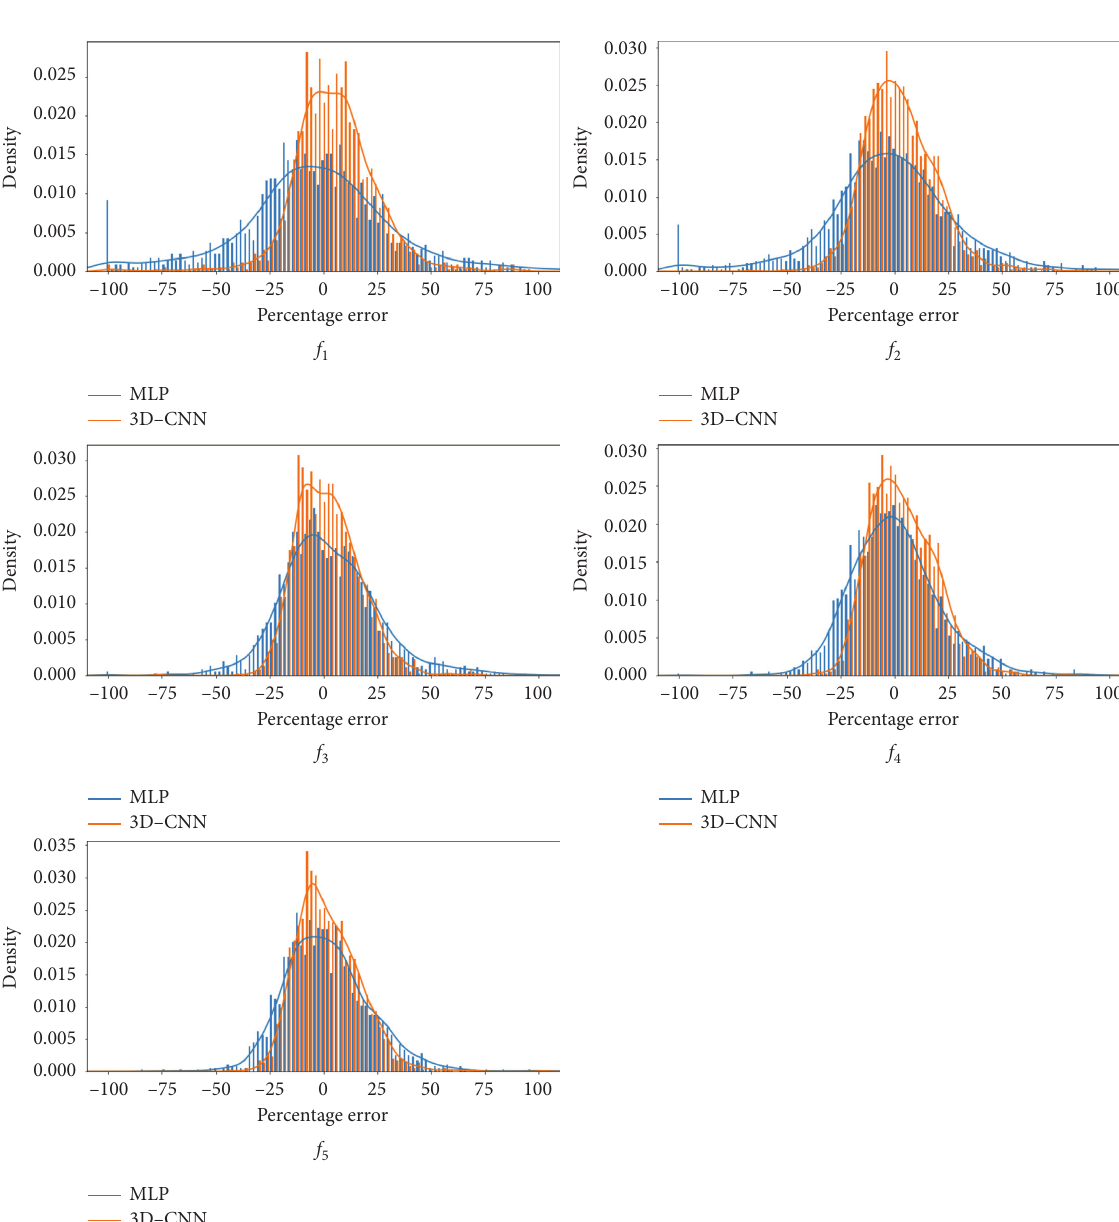
Figure 7: Percentage error distribution of 3D-CNN and